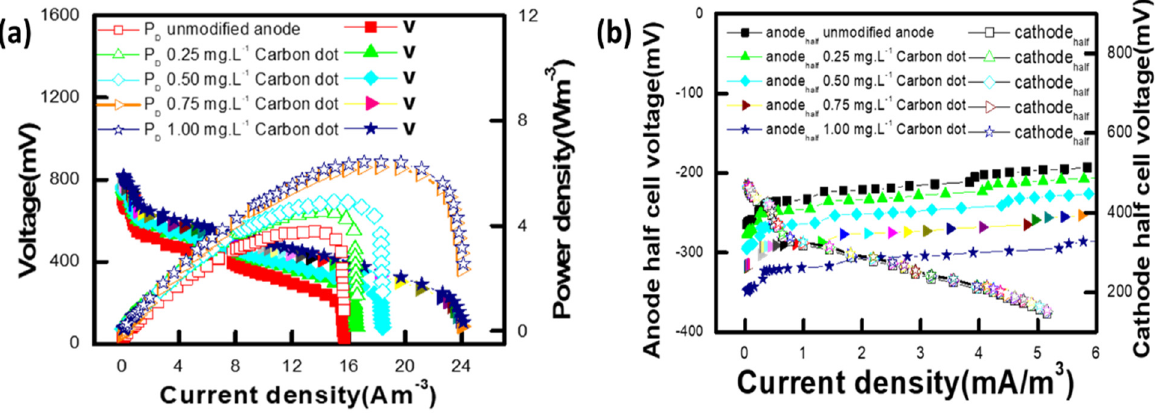
Figure 6. ( a ) Polarization plots for MFCs (power density and D.C. voltage as a function of current density) with different concentrations of (1 mg/cm 2 to 0.25 mg/cm 2 ) CD loaded anode (full-cell and half-cell). The power density and voltage data points are presented as solid and open symbols. ( b ) . Anode and cathode polarization curves of sMFC with different concentrations of carbon dot supplemented to the anode surface. Open and solid symbols represent cathode and anode half-cell voltages, respectively.